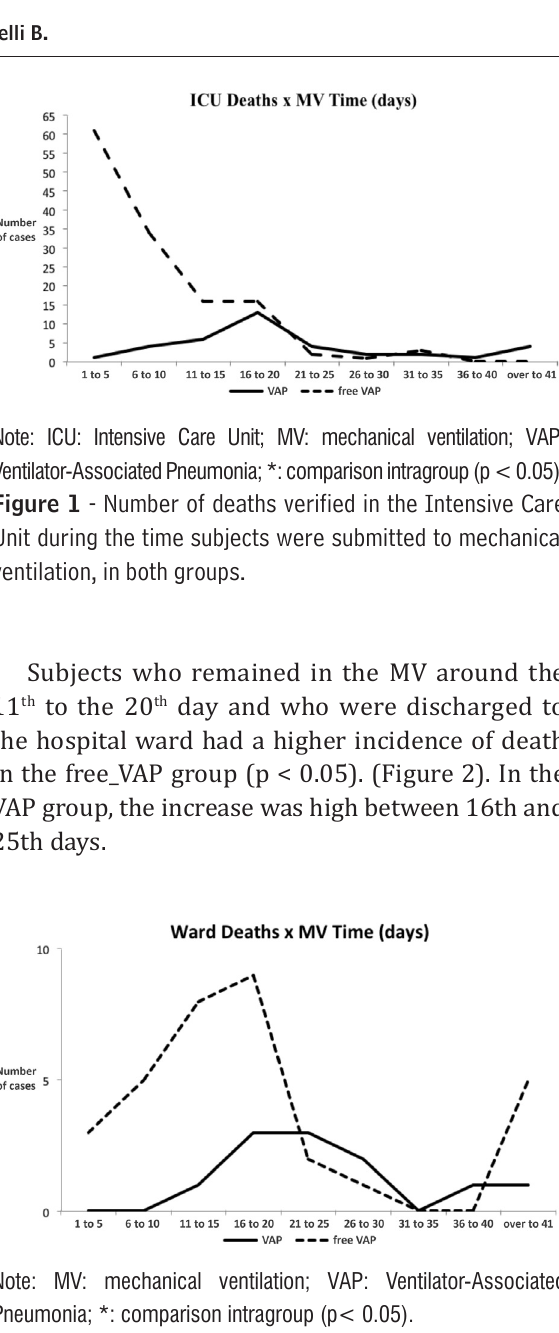
Figure 2 - Number of deaths verified at the hospital ward unit versus time of mechanical ventilation in both